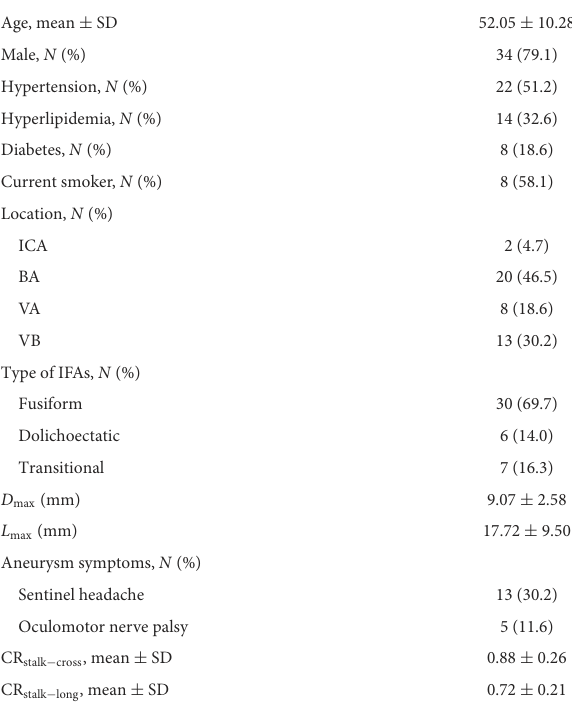
characteristics and aneurysm symptoms.